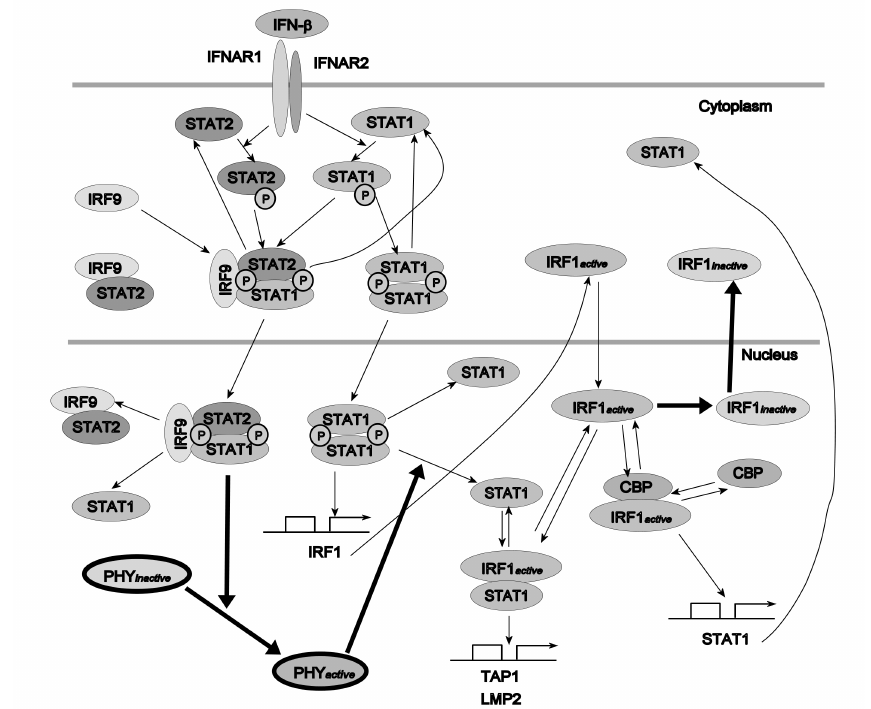
Figure 7. Schematic diagram of the IFN- β -induced JAK/STAT signaling pathway model. PHY active and PHY inactive represent unknown active and inactive phosphatases, respectively, hypothesized in the model [1].